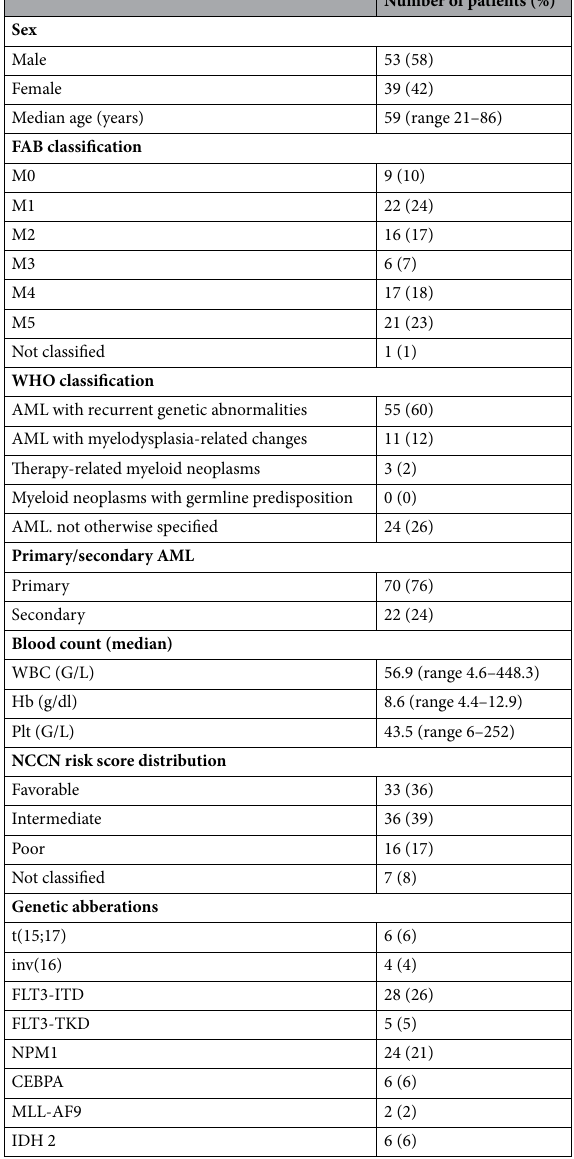
Table 1. Patient characteristics. AML acute myeloid leukemia; FAB French-American-British; WBC white blood count; Hb hemoglobin; Plt thrombocytes; NCCN National Comprehensive Cancer